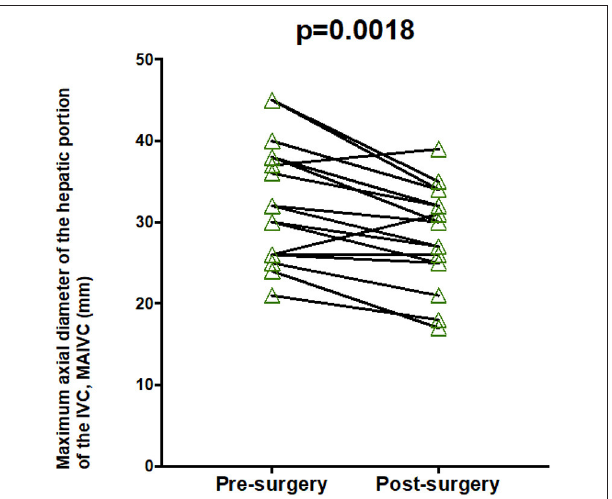
FIGURE 8 | Maximum long axis of hepatic IVC pre- and